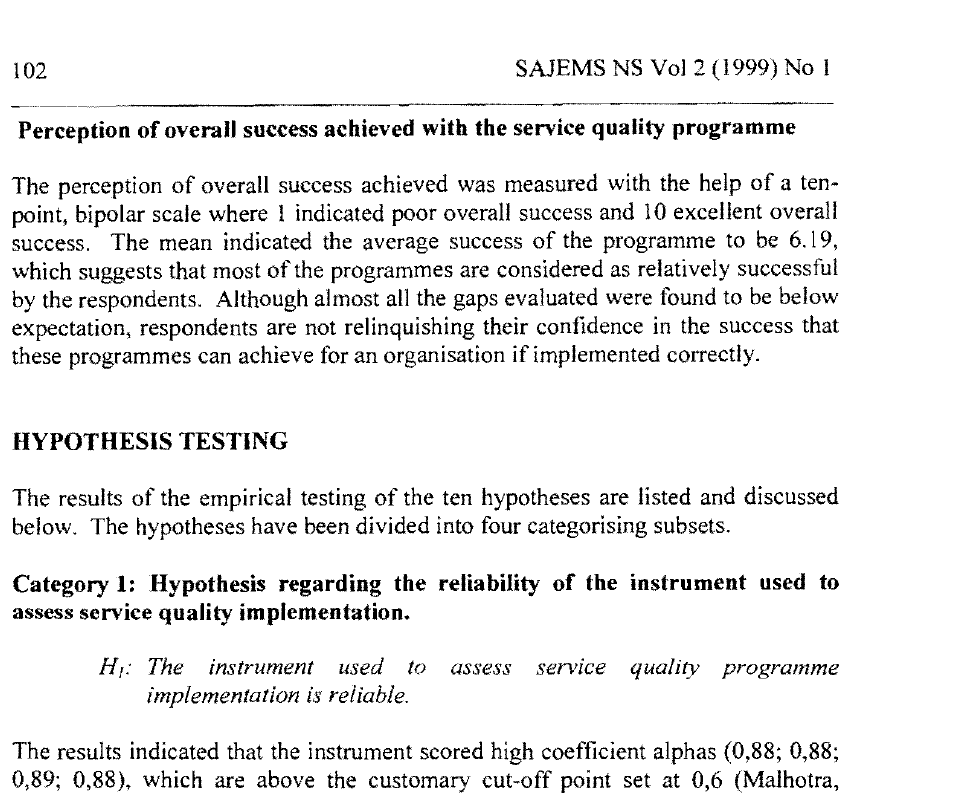
Testing of hypothesis 2 in terms of external and internal drivers